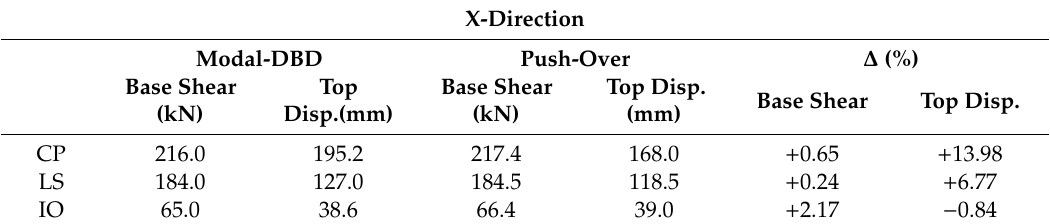
Table 10. Comparison between base shear forces and top displacements obtained by Modal-DBD